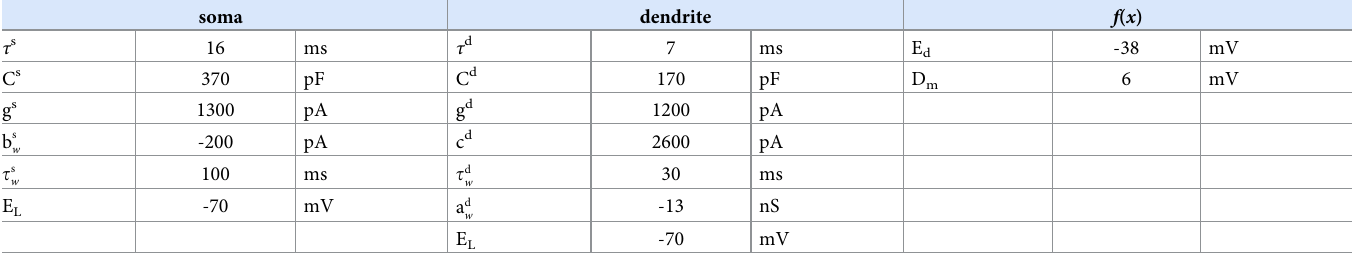
Table 1. Parameter values for the two-compartmental PC model. Soma and dendrite indicate the somatic and dendritic compartment respectively and f ( x ) the sigmoid function. Values are from [17]. soma dendrite f ( x ) τ s 16 ms τ d 7 ms E d -38 mV C s 370 pF C d 170 pF D m 6 mV g s 1300 pA g d 1200 pA -200 pA c d 2600 pA b s w t s 100 ms t d 30 ms w w E L -70 mV a d -13 nS w E L -70